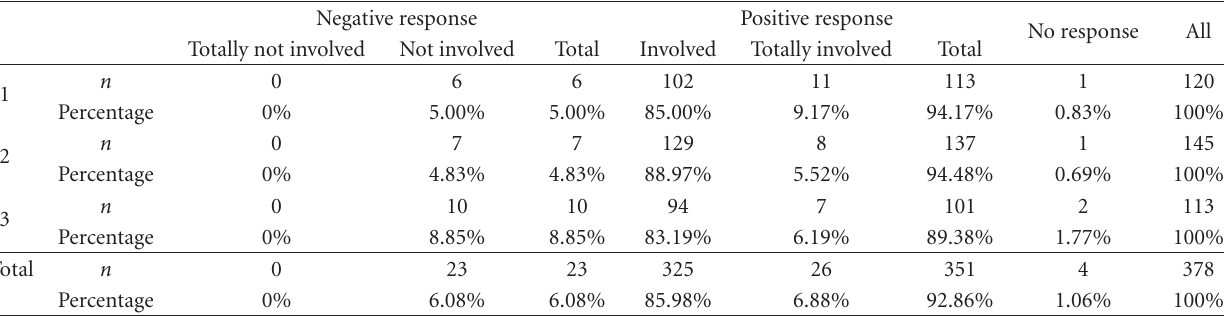
Table 2: Degree of student involvement perceived by the program